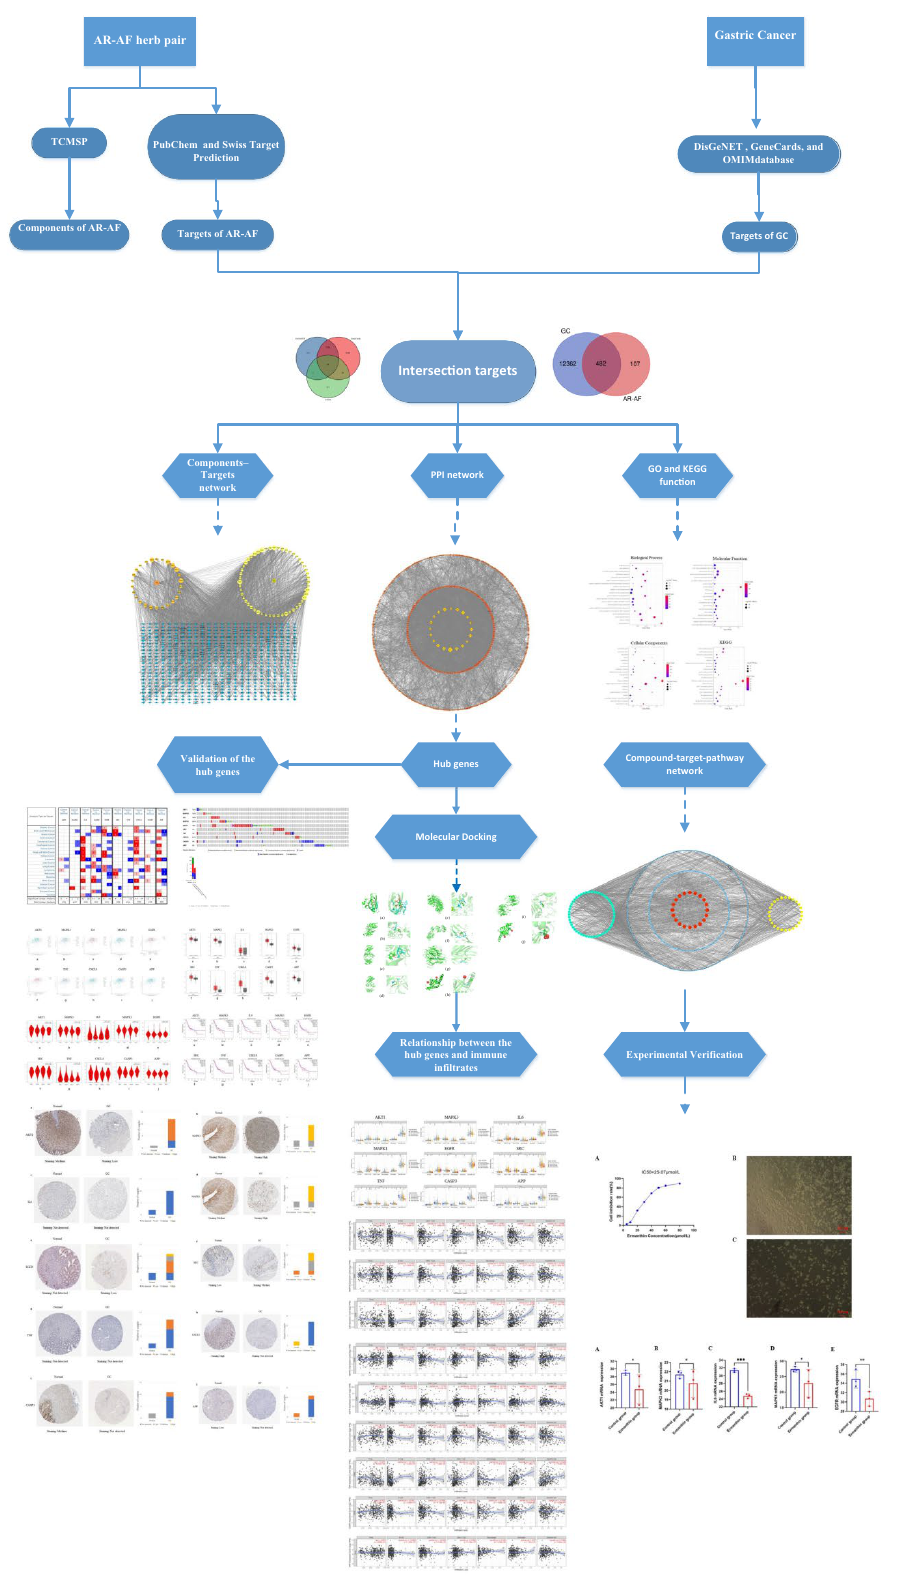
Figure 1. The protocol of our study